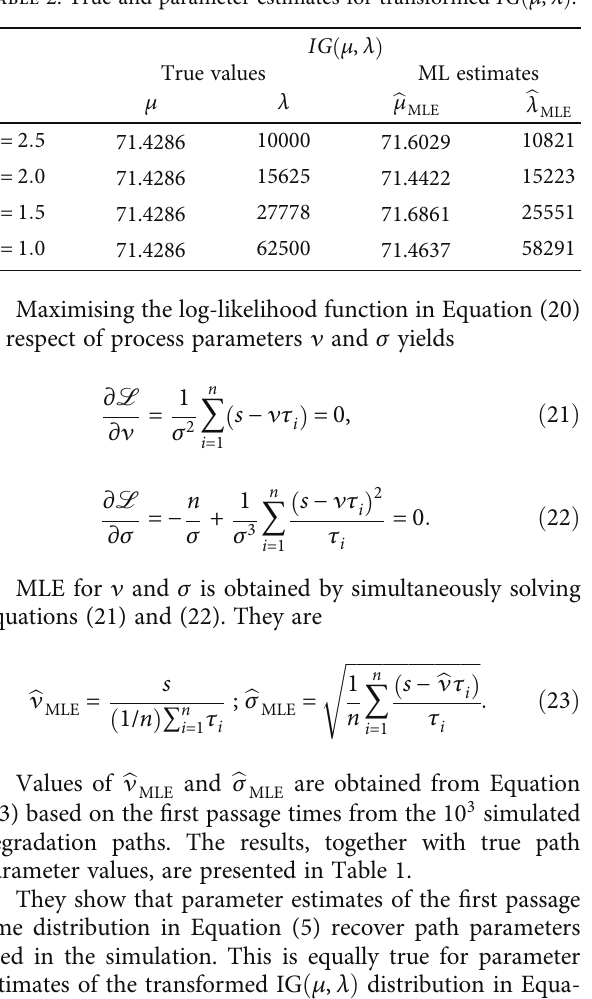
Table 2: True and parameter estimates for transformed IG ð μ , λ Þ